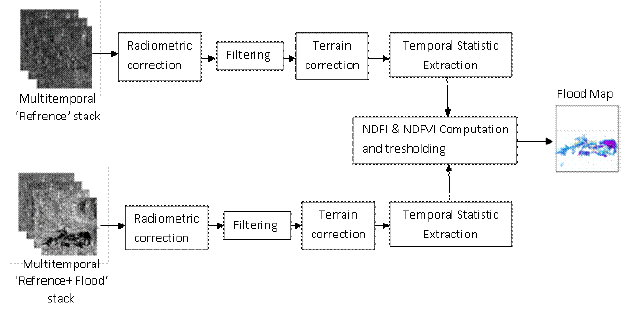
Figure 1. The methodology proposed consists in creating two stacks of images: one containing only reference images and one containing also images of the flood under investigation. The two stacks are then radiometrically calibrated and terrain corrected. Temporal statistics are extracted to compute the Normalized Difference Flood Index (to highlight temporary open water bodies) and the Normalized Difference Flood in Vegetated areas Index (to highlight shallow water in short vegetation). A threshold is finally applied to the indices values to extract only flooded areas. Additional filtering is applied to remove spurious cluster of